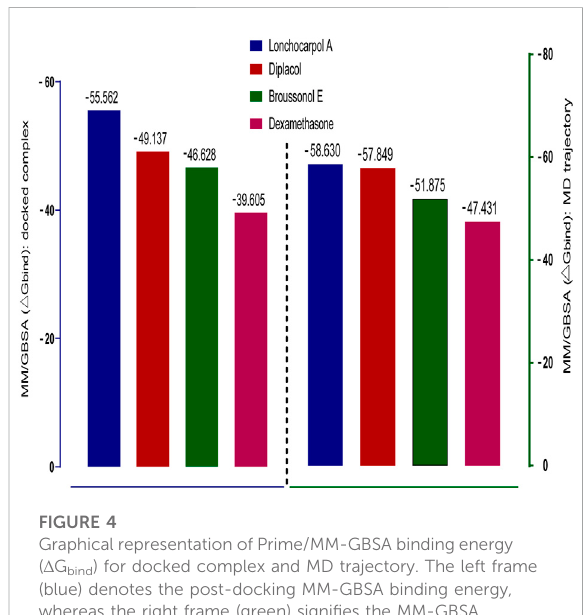
FIGURE 4 Graphical representation of Prime/MM-GBSA binding energy ( Δ G bind ) for docked complex and MD trajectory. The left frame (blue) denotes the post-docking MM-GBSA binding energy, whereas the right frame (green) signi fi es the MM-GBSA binding energy of post-simulation analysis.